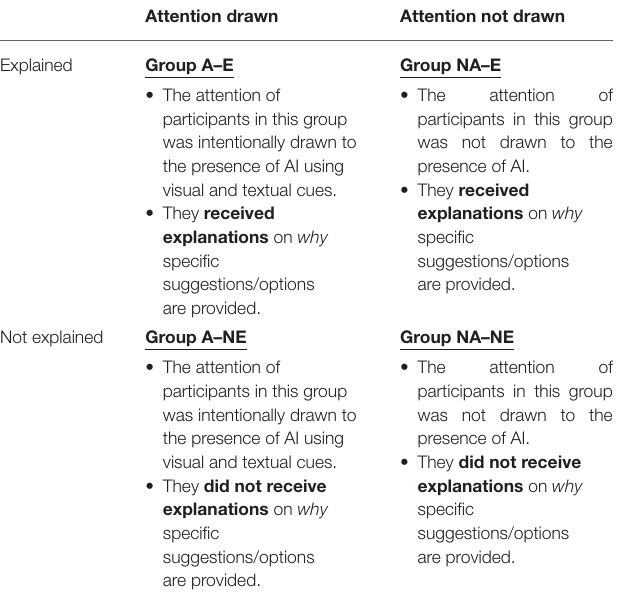
TABLE 1 | Overview of manipulations in the study design. Attention drawn Attention not drawn Explained